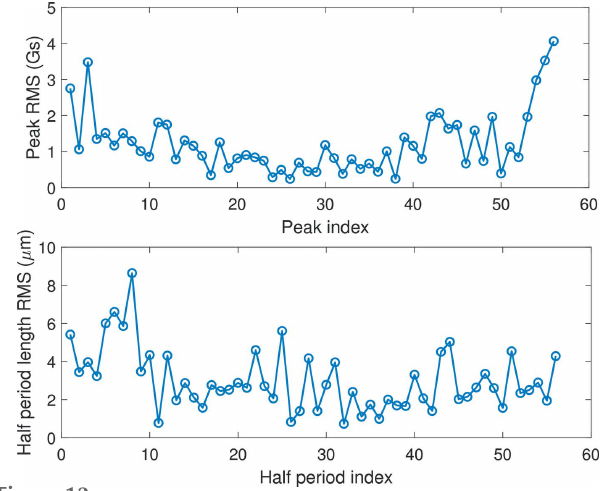
Figure 12 The measurement RMS error of the peak magnetic field and the half- period length.